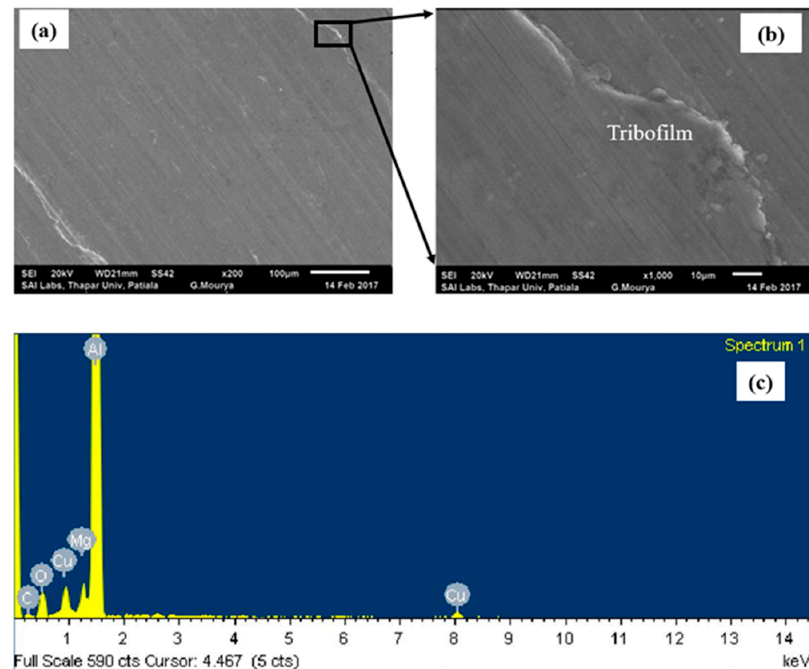
Figure 7. ( a ) SEM image of worn surface of the aluminium alloy disc lubricated with PAO + CuO + ND nanolubricant at 50 N load (200×) ( b ) magnified image (1000×) of Figure 7a; and ( c ) EDS spectrum of Figure 7a. Tribofilm formation can be seen on the worn surface. In the EDS spectrum, carbon (C) peak indicates the presence of ND particles on the worn surface.